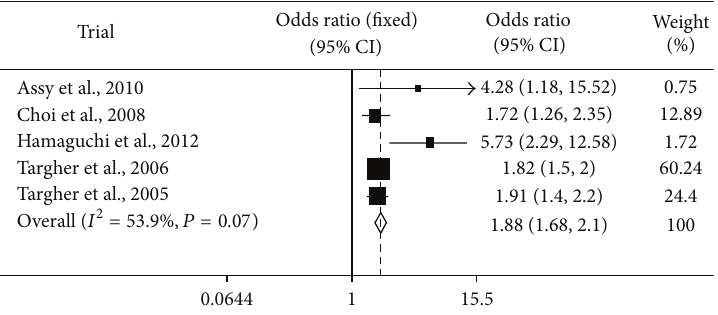
Figure 2: Summary estimates for Mantel-Haenszel odds ratios, the corresponding 95% CI limits, and significance ( 𝑃 value) were estimated by fixed effects metaregression analysis for cardiovascular disease between the two groups (NAFLD patients and controls). In the graph, numbers indicate OR values, filled squares stand for the effect of individual studies, and the diamond expresses combined fixed effects.